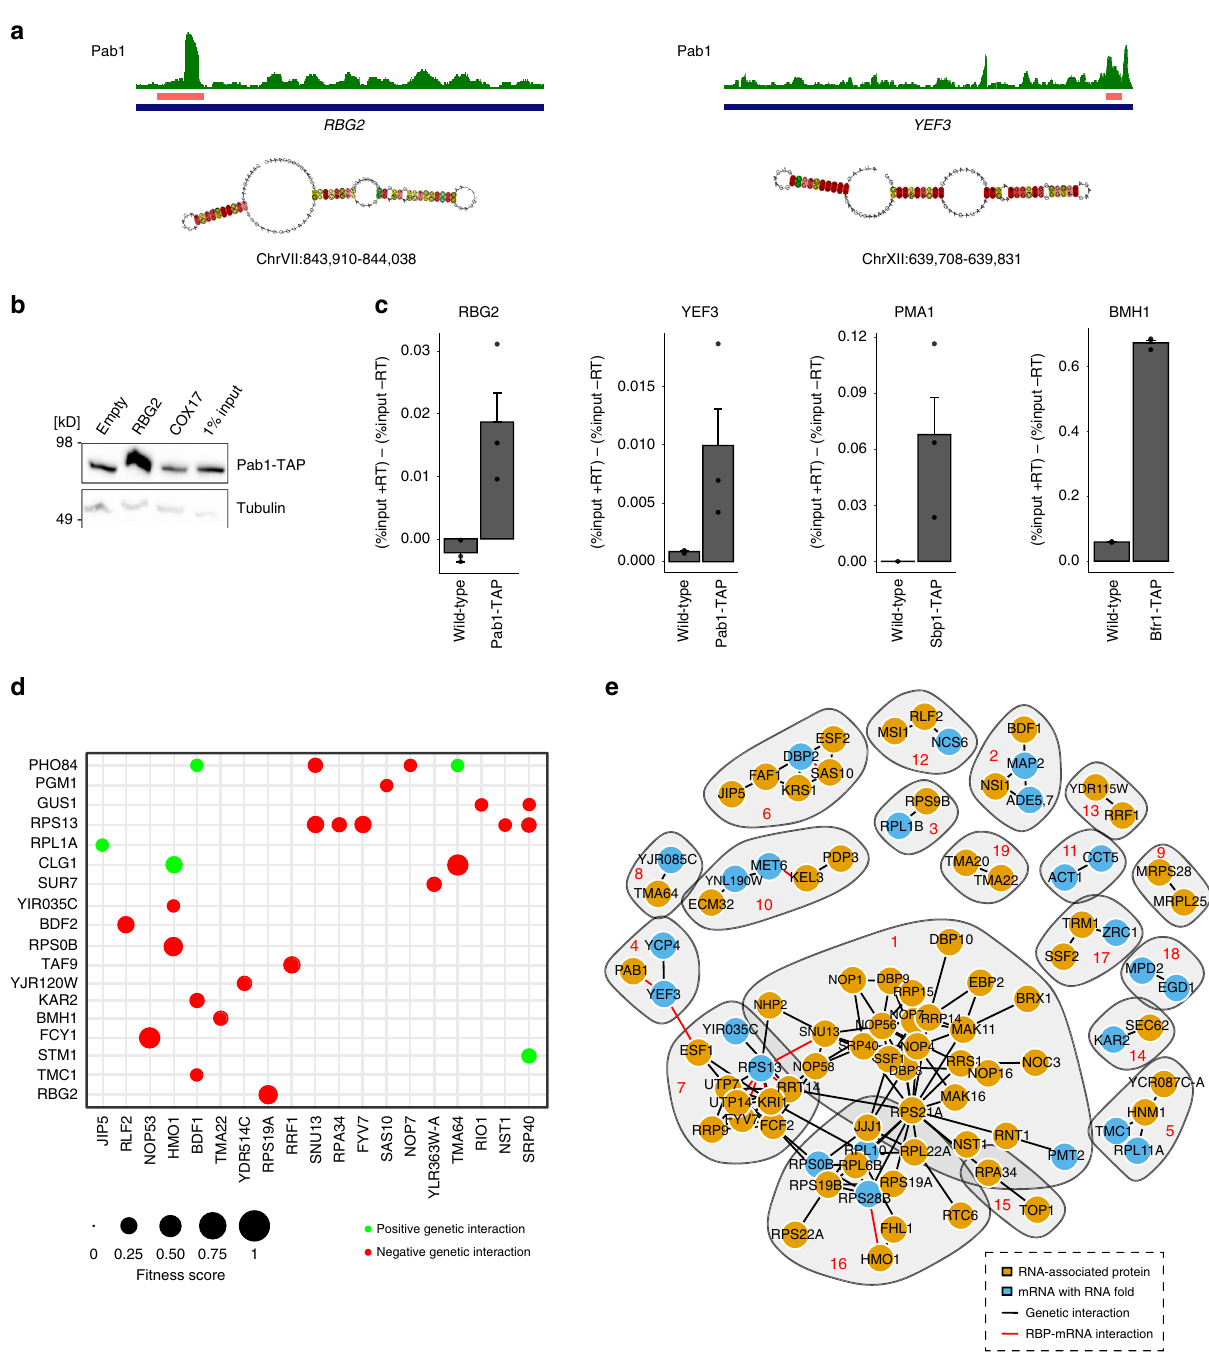
Fig. 3 Integration of in vivo localization and genome-wide genetic interaction data provide functional insights into our set of interactors. a Pab1 PAR- CLIP data show a signi fi cant peak on both RBG2 ( p -value = 1.5e − 14 ) and YEF3 ( p -value = 9.1e − 9 ) target genes and overlap with the conserved RNA fold region (colored salmon). Folded structures are shown, with positional entropy values ranging from red/yellow (lower entropy) to green/blue (higher entropy). b Pull-down and Western blotting on a TAP-tagged Pab1 strain validated Pab1 binding to the RBG2 RNA fold. c RNA immunoprecipitation (RIP) experiments in wild-type and endogenously TAP-tagged strains show enrichment of target RNAs in Pab1 (for RBG2 and YEF3 ), Sbp1 (for PMA1 ) and Bfr1 (for BMH1 ). Results are shown relative to input signals normalized to the − RT (no reverse transcriptase) conditions. Data are presented as mean ±SEM values in n = 3 technical replicates. d Matrix showing genetic interactions described for our RBP ( x axis) and RNA fold ( y axis) interacting pairs. Genetic interactions with a fi tness score > 0.08 are colored according to positive (green) and negative (red) interactions. The circle size is proportional to the fi tness score of the double knock-out strain of the two relevant genes. e Clustering of our RBP candidate genes and mRNA genes according to the genetic interaction pro fi le correlations (similar genetic interaction pro fi les considered upon PCC values > 0.2). Red numbers indicate the ID of the respective gene community (Supplementary Data